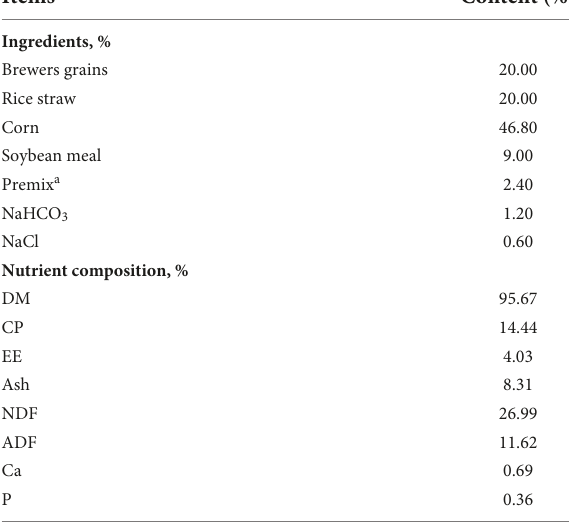
TABLE 1 Composition and nutrient levels of the basal diet (dry matter